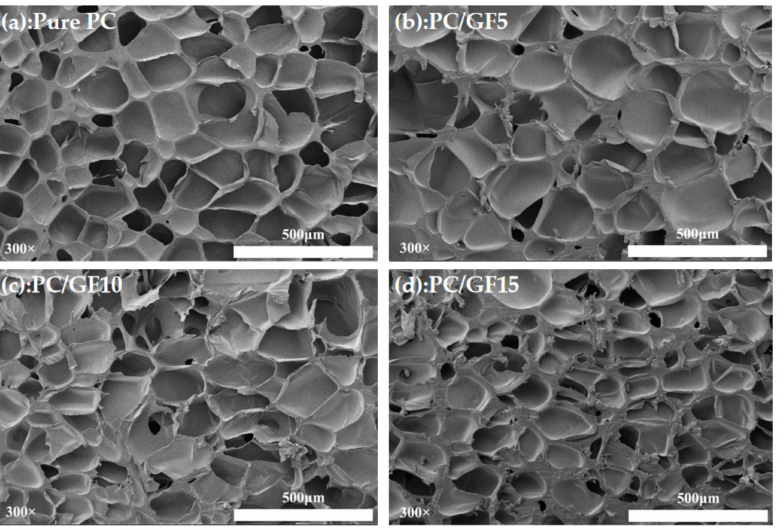
Figure 6. SEM micrographs of foamed PC and PC/GF composites with the GF loading (wt%). ( a ) 0%, ( b ) 5%, ( c ) 10%, ( d ) 15%.